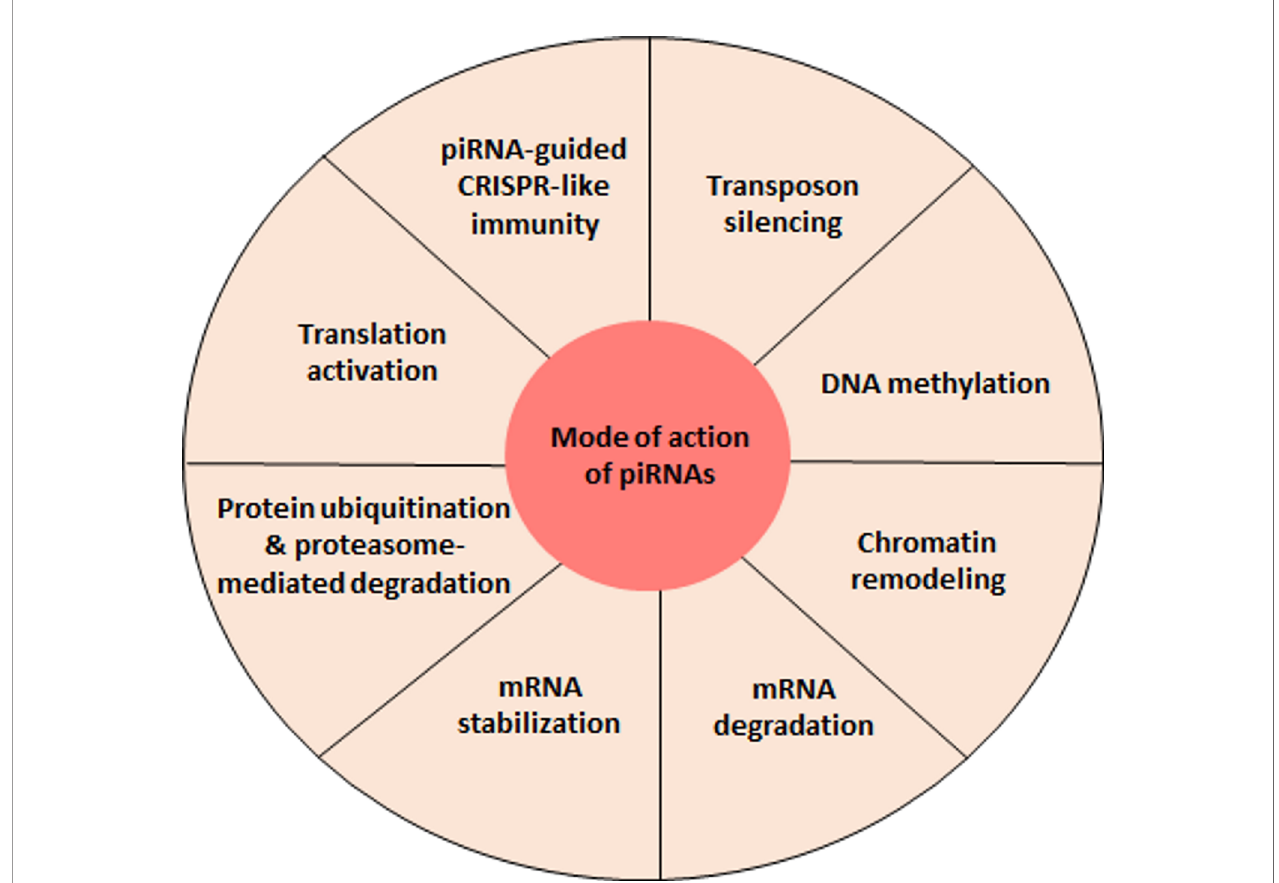
FIGURE 2 | piRNA-mediated regulatory functions. At present, the best characterized function of piRNAs is the repression of transposable elements. However, recent evidence indicates that piRNAs can accomplish a variety of other regulatory activities, fi ndings that will most certainly be further strengthen by future